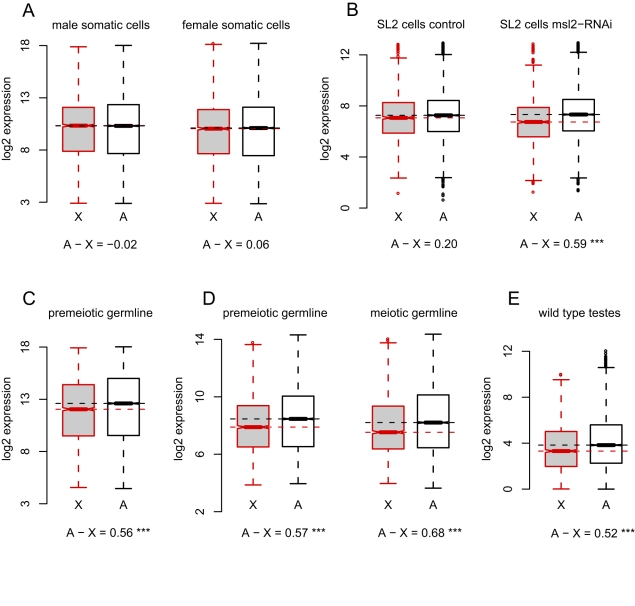

X chromosome and autosomal gene expression are consistent with no dosage compensation in Drosophila primary spermatocytes.(A) Autosome and X chromosome expression in cells in the male thorax and female thorax. (B) Autosome and X chromosome gene expression from control cells and from SL2 cells in which dosage compensation has been knocked down by RNAi against msl2
[43]. (C–E) Autosome and X chromosome gene expression in the male germline. Premeiotic cells were dissected from the apical tip of the testes; meiotic cells were dissected from the proximal region of the testes. Data in (C) are from Agilent Drosophila gene expression microarrays; (D) shows previously published data [41] using Affymetrix GeneChips. (E) Previously published [48] RNA-seq data from wild-type testes. *** p<0.001 (Mann-Whitney test).